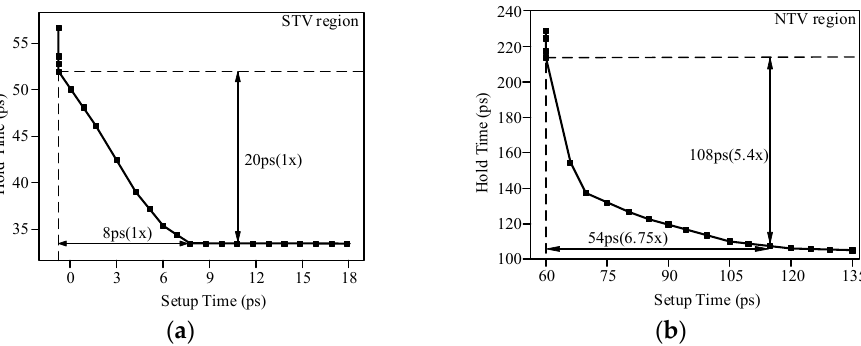
Figure 5. Setup–hold time curves under 40 nm proces s in ( a ) STV region, 1.1 V, 25 °C, TT corner; ( b ) NTV region, 0.6 V, 25 °C, TT corner.